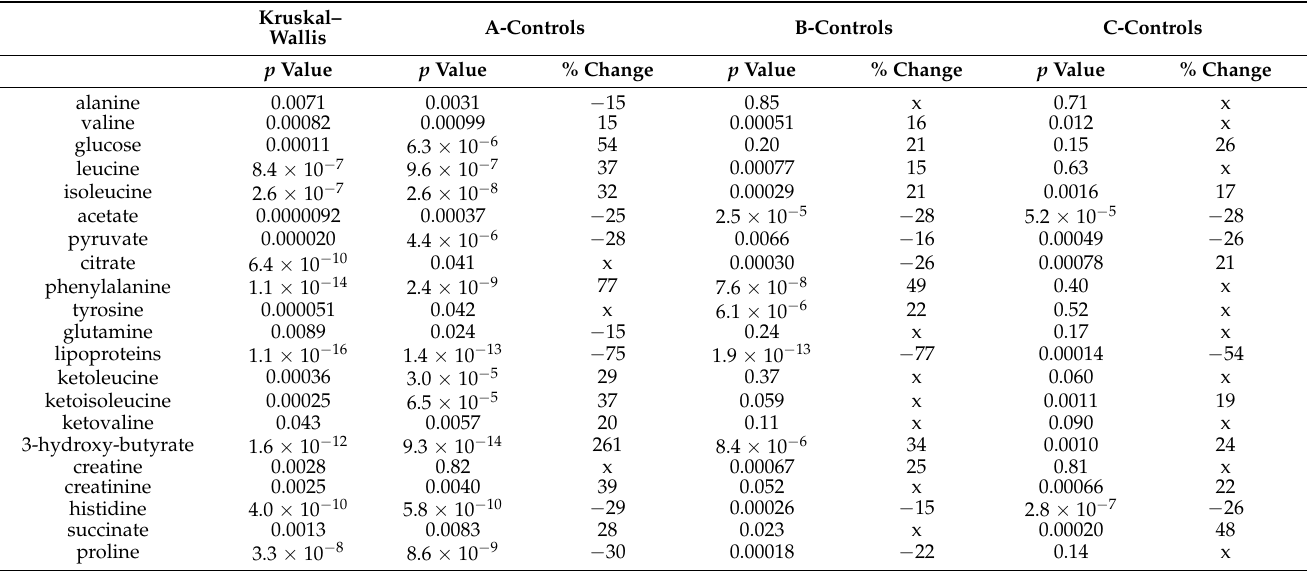
Table 1. Statistical evaluation based on the Kruskal–Wallis test for multiple comparison and post hoc Dun’s tests for pairwise comparison, percentual change derived from medians, algorithms used relative concentrations of metabolites in blood plasma.